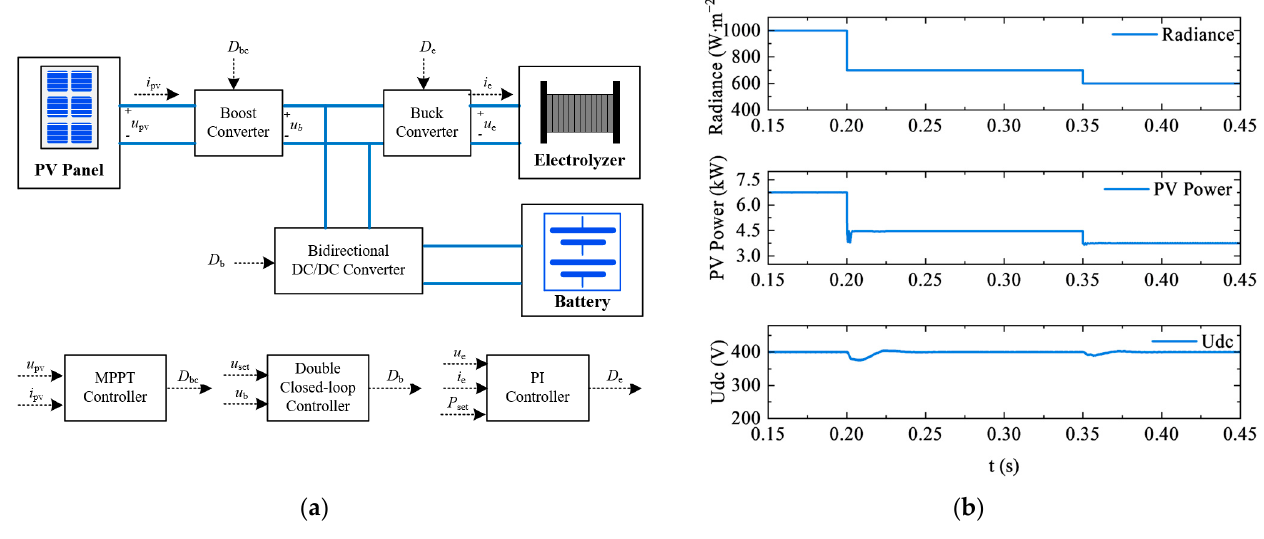
Figure 7. System electrical control strategy and its result. ( a ) The electrical control strategy for each component; ( b ) the system response under radiation disturbances.